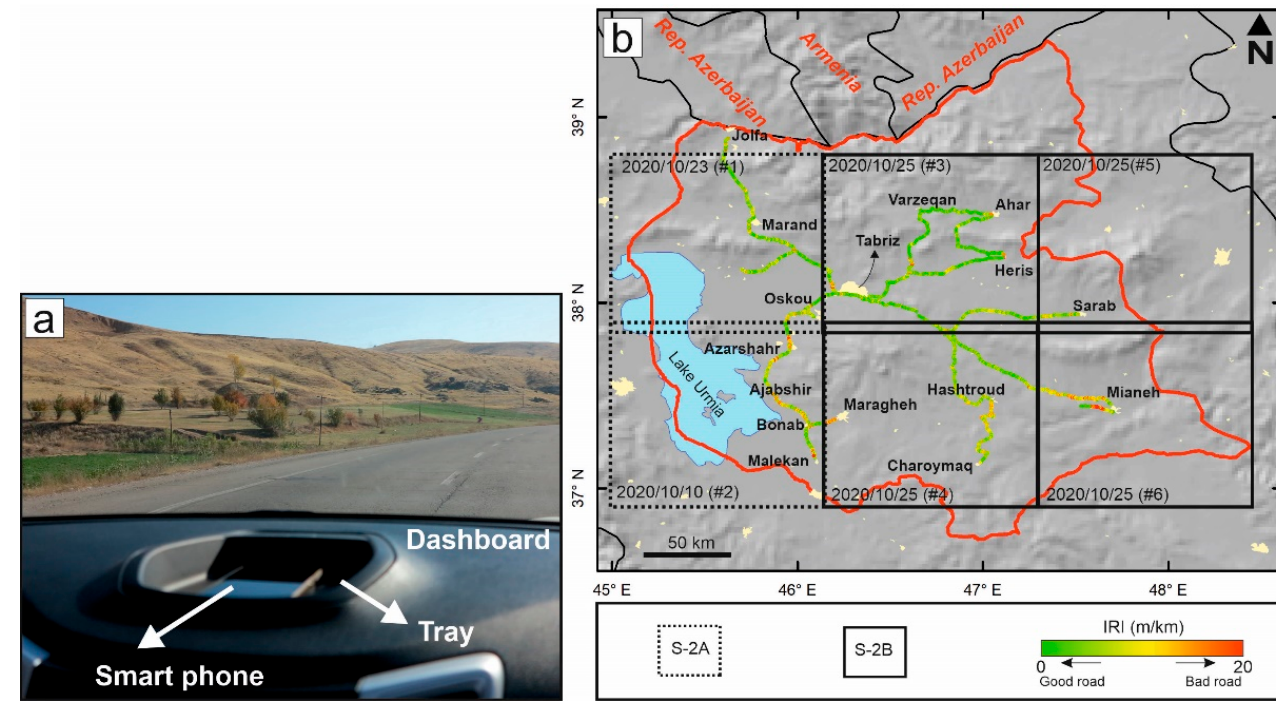
Figure 2. ( a ) Setup for conducting international roughness index (IRI) measurements in East Azerbaijan Province using a quarter car (QC) and a smartphone. ( b ) The resulting back-and-forth in situ IRI measurements in East Azerbaijan Province of Iran from Tabriz along the primary roads leading to the other counties. Black boxes show the areas covered by Sentinel-2 images of the province. Dashed boxes indicate the images acquired from Sentinel-2A, and solid black boxes indicate the images acquired from Sentinel-2B.